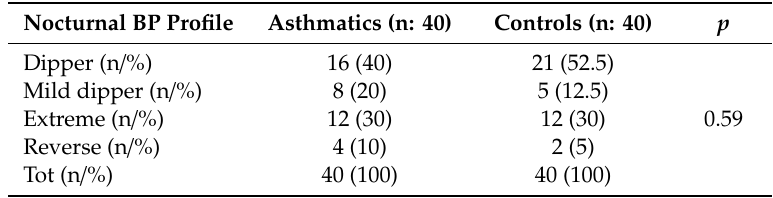
Table 3. Nocturnal dipping patterns—asthmatics vs.